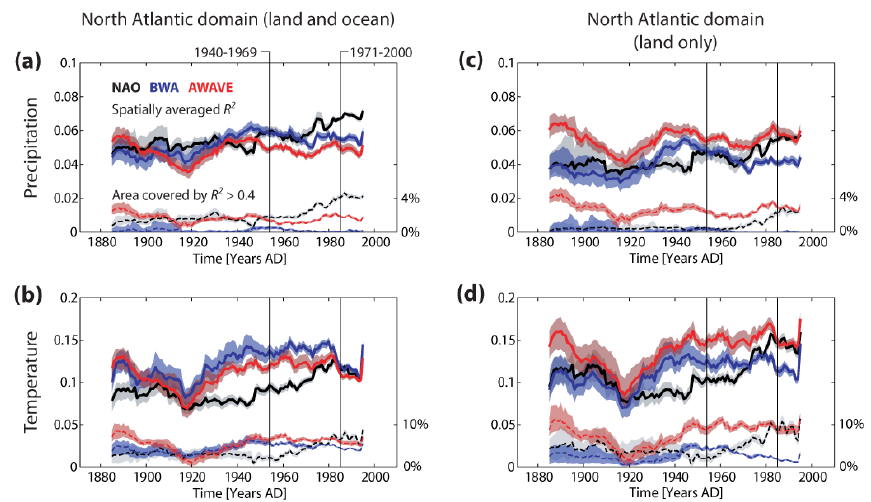
Fig. 8. Explanatory power of teleconnection modes in TCR. ( a ; upper lines, left y axis) 30-year moving spatially averaged coefficient of determination R 2 of the NAO, BWA, and AWAVE for precipitation over the North Atlantic domain (see text and Fig. 7 for details on domain and indices). ( a ; lower lines, right y axis) 30-year moving average of fraction of domain area where R 2 > 0.4. Vertical lines mark the two periods shown in Fig. 7. (b) Same as (a) but for temperature. (c, d) Same as (a, b) but for the North Atlantic land only. Shown is the range of the ensemble members and the ensemble mean of the individual